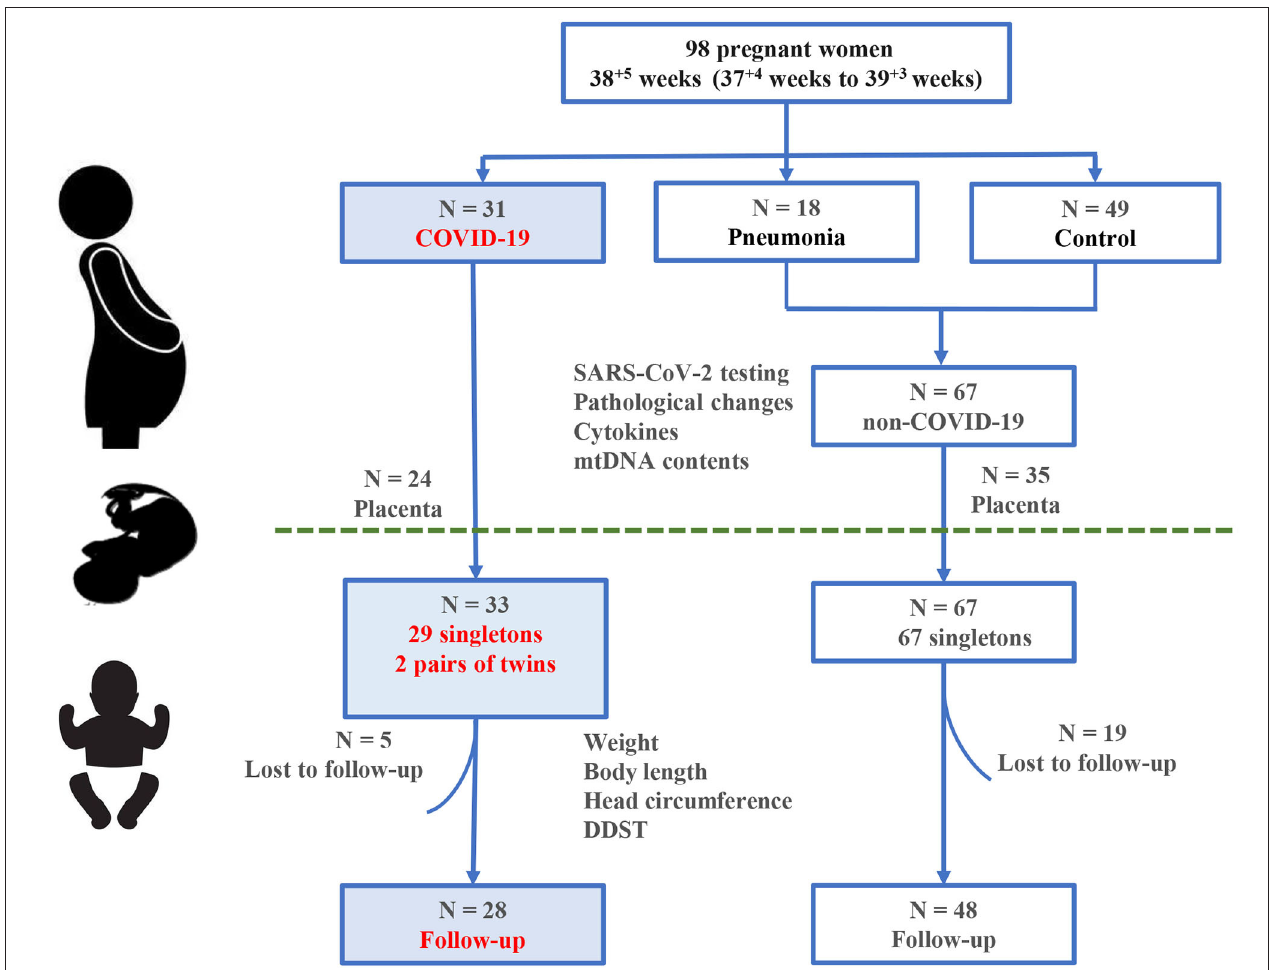
FIGURE 1 | Study design and participants. A total of 98 pregnant women and 100 infants born to them are included in this